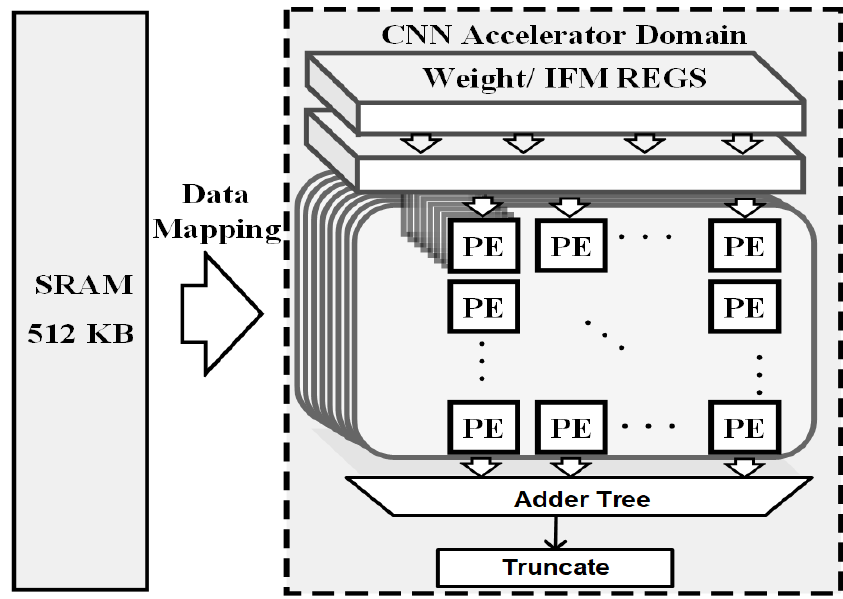
Figure 6. The adopted DLA architecture diagram. Table 1. Synthesis results of the DLA.